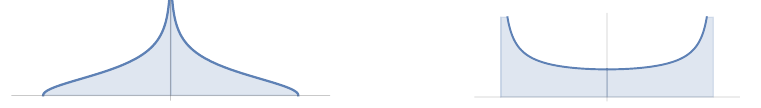
Figure 3 . When ϕ → 0 , the cusp moves to the origin and the density becomes singular at t = 0 (left). When ϕ → ∞ , the